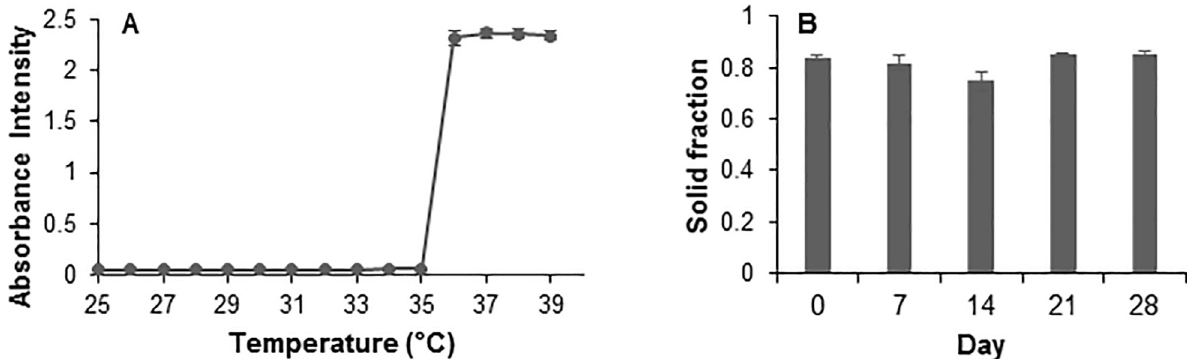
Fig 2. Thermoresponsive pNIPAAm gel properties. Characterization of gel properties, including (A) least critical solution temperature (LCST) determined via absorbance measurement at 415nm and (B) degradation at 37˚C over 28 days. Error bars represent the average ± standard error for n = 3 gel samples. Degradation samples were analyzed for significance (p < 0.05) using Student’s t-test at each time point.